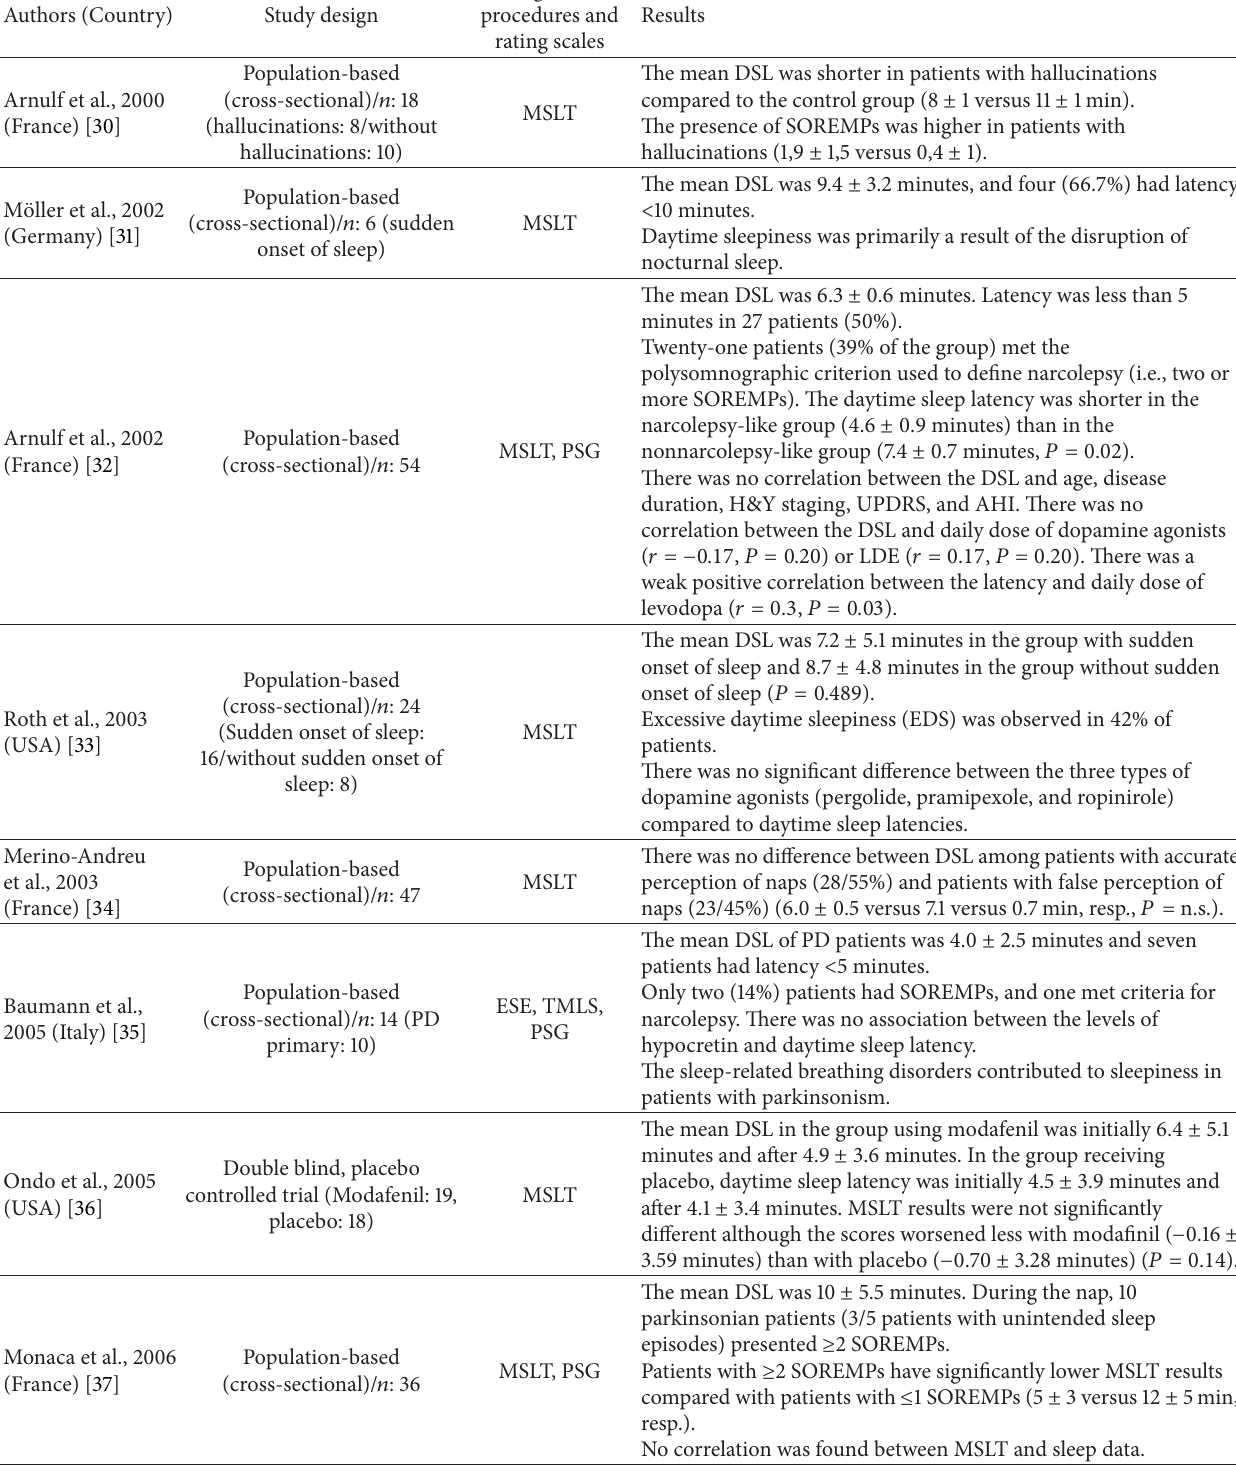
Table 2: Characteristics and results of MSLT studies in patients with Parkinson’s disease with complaints of sleepiness ( 𝑛 : 9). Authors